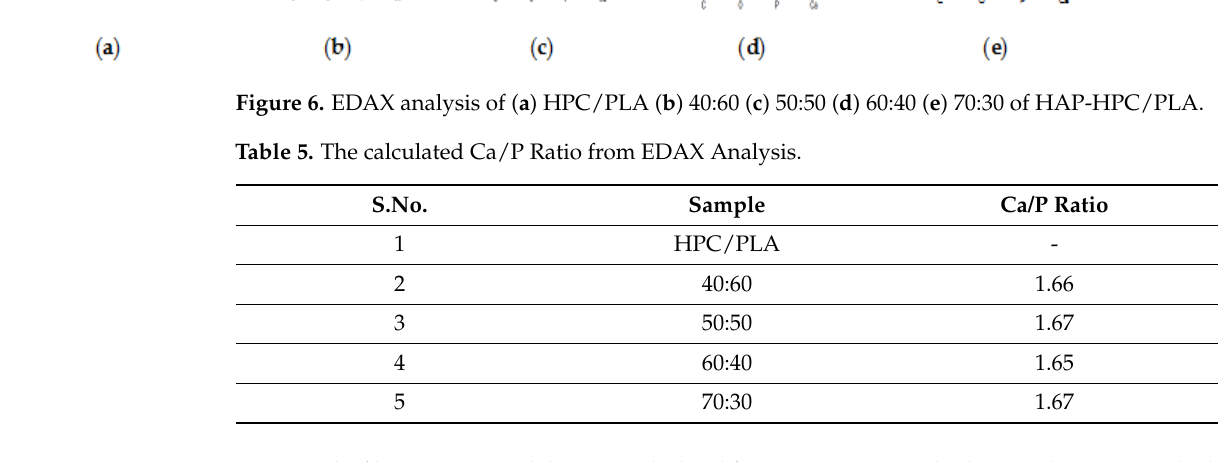
Table 6. The fiber pore size and diameter calculated from SEM images and solvent replacement method.